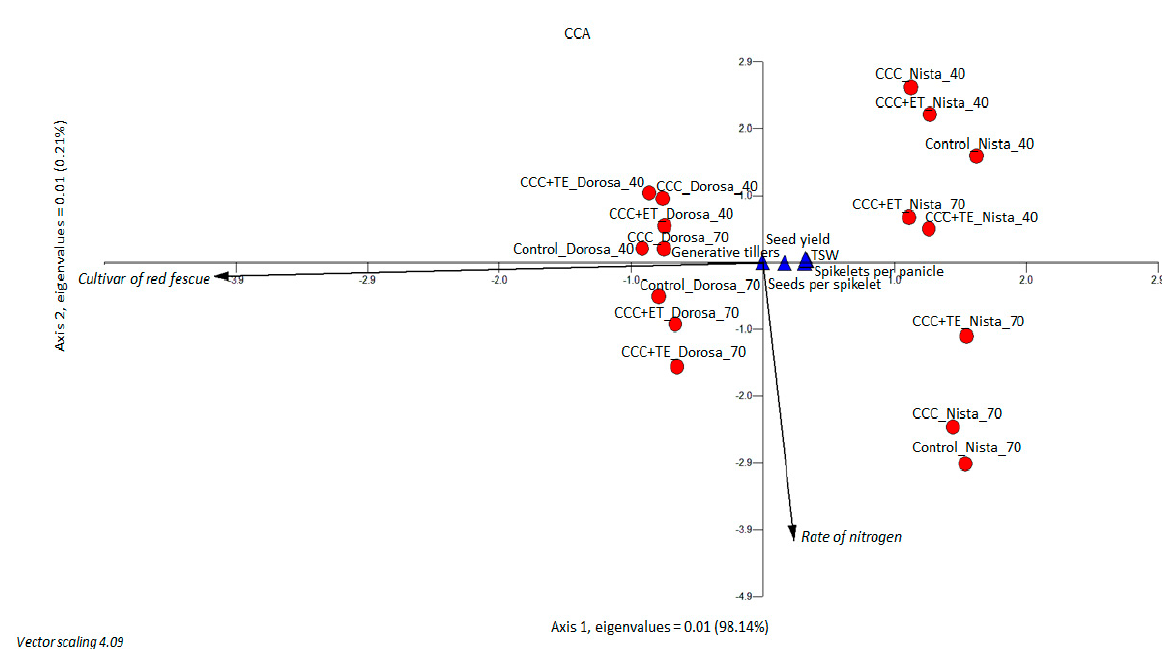
Figure 2. Canonical correspondence analysis (CCA) for seed yield, generative tillers, spikelets per panicle, seeds per spikelet and TSW of Festuca rubra ssp. rubra cv. Nista and F. r . ssp. commutata cv. Dorosa depending on plant growth regulator and nitrogen fertilization rate; eigenvalues for axis 1 ʎ = 0.01 (98.14%), for axis 2 ʎ = 0.01 (0.21%), significance of first axis: Monte Carlo-permutation test: (F-ratio = 4.23, p = 0.001), significance of second axis: Monte Carlo-permutation test: (F-ratio = 1.03, p = 0.135).